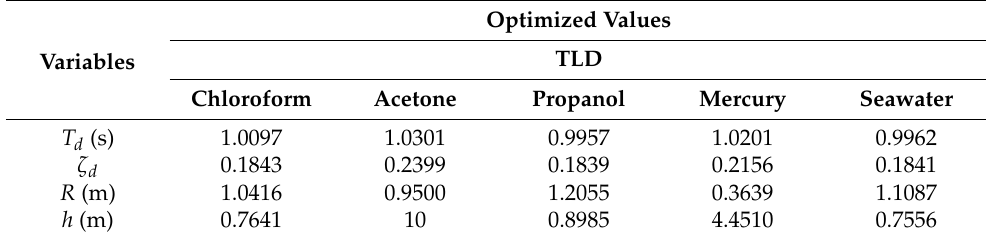
Table 7. Optimum results for all TLD liquids in the 10-story structure.